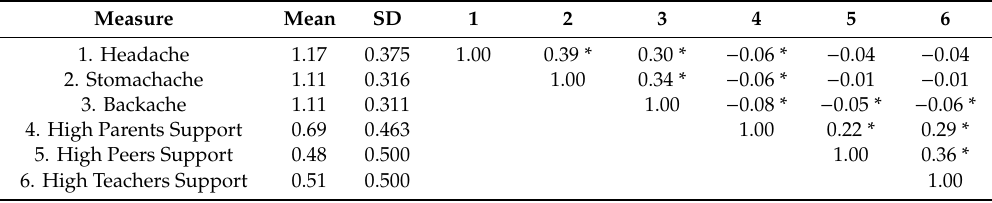
Table 4. Inter-correlations and descriptive statistics of somatic complaints and social